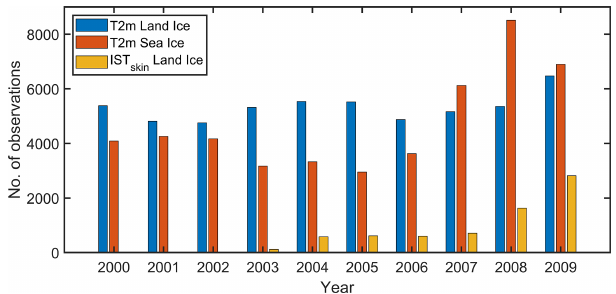
Figure 1. Total number of daily averaged in situ observations of T2m and IST skin over Arctic land ice and sea ice per year covering the period